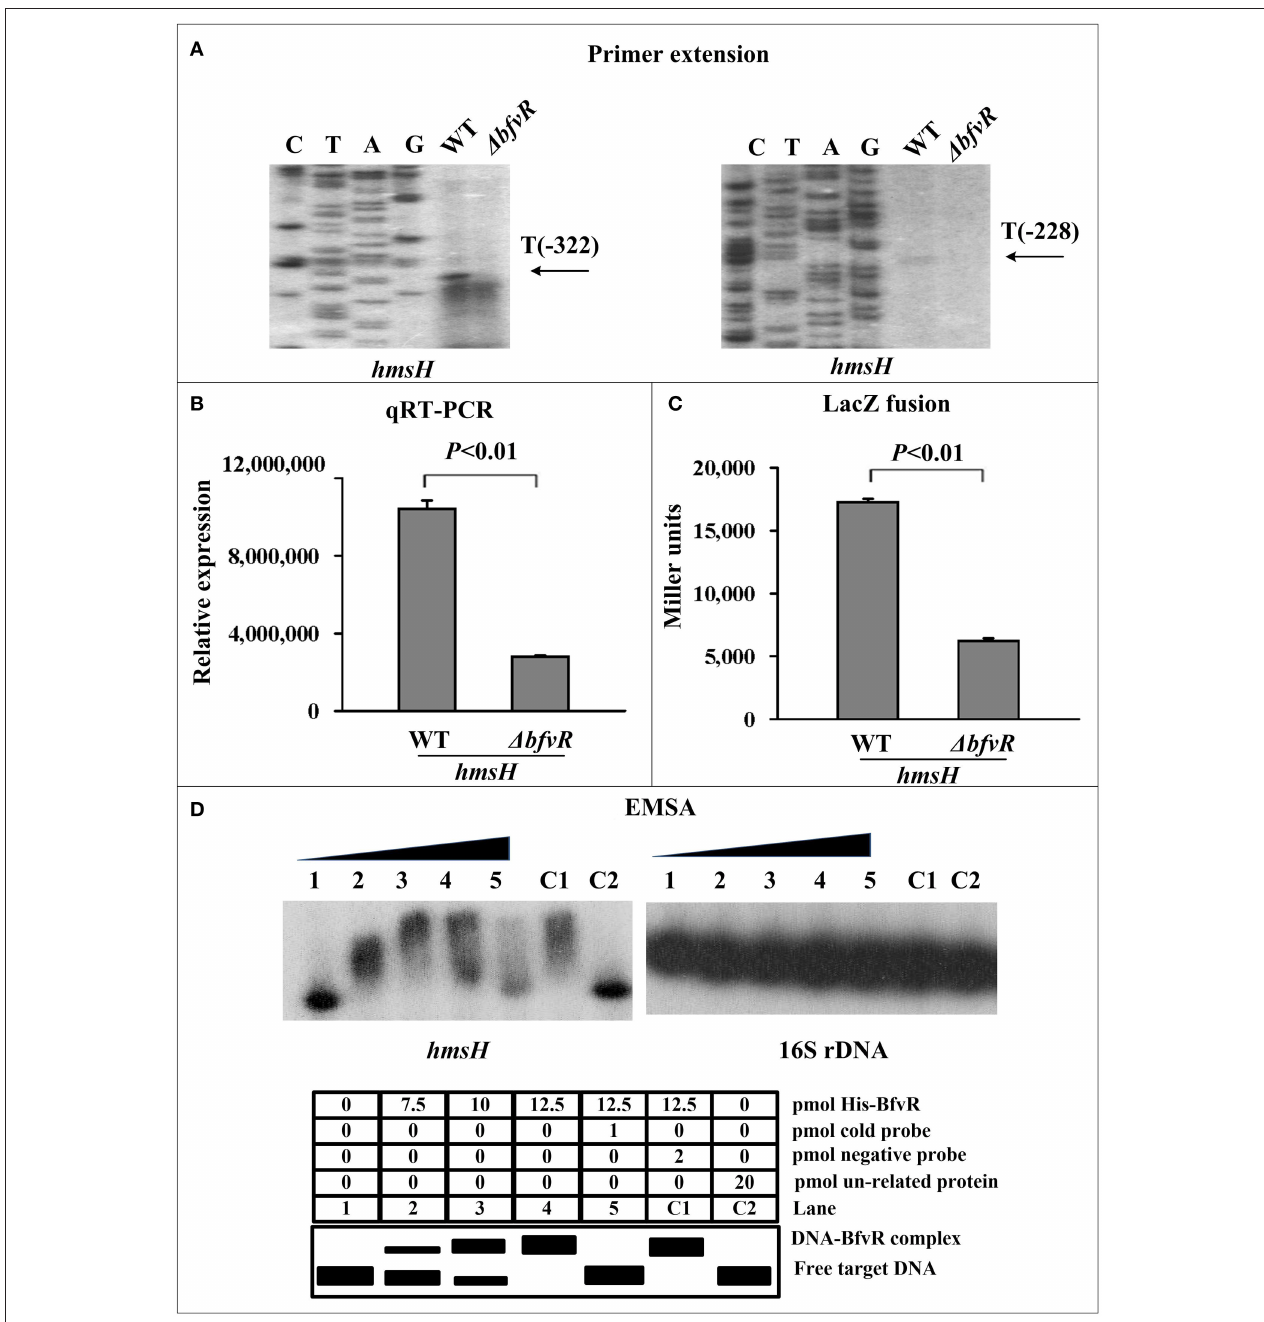
FIGURE 2 | Regulation of hmsH transcription by BfvR. Lanes G, A, T, and C represented Sanger sequencing reactions. Symbols + and – indicated the nucleotide positions downstream and upstream of the translation start site of target gene, respectively. (A) Primer extension. A( − 128) represents the transcription start site of hmsH . (B) Quantitative RT-PCR. The relative mRNA expression was determined by calculating the threshold cycle (Ct) of hmsH via the classic 2- 11 Ct method through standardized by the 16S rRNA gene. (C) LacZ fusion. LacZ reporter fusion with the promoter-proximal region ( − 451… + 103) of hmsH and β -galactosidase in cellular extracts were determined. (D) EMSA. Purified His-BfvR protein bound to the promoter-proximal fragment of hmsH labeled radioactively and the retarded DNA band were shown in the amount-dependent manner. and (iv) determination of intracellular c-di-GMP levels by